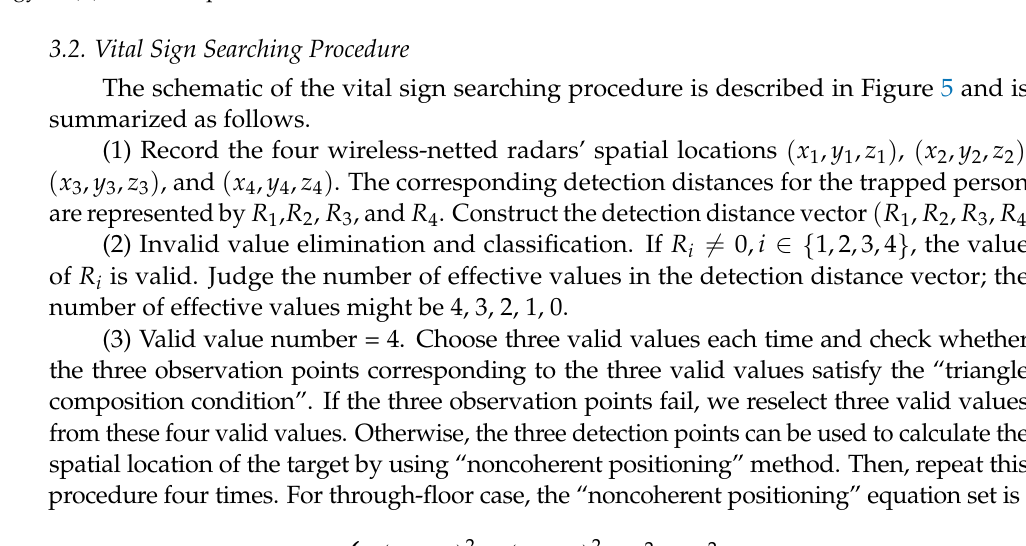
Figure 4. Different MIMO array topologies and effective aperture with different scores. ( a ) Topology-I; ( b ) effective aperture with 36 score; ( c ) Topology-II; ( d ) effective aperture with 28 score.